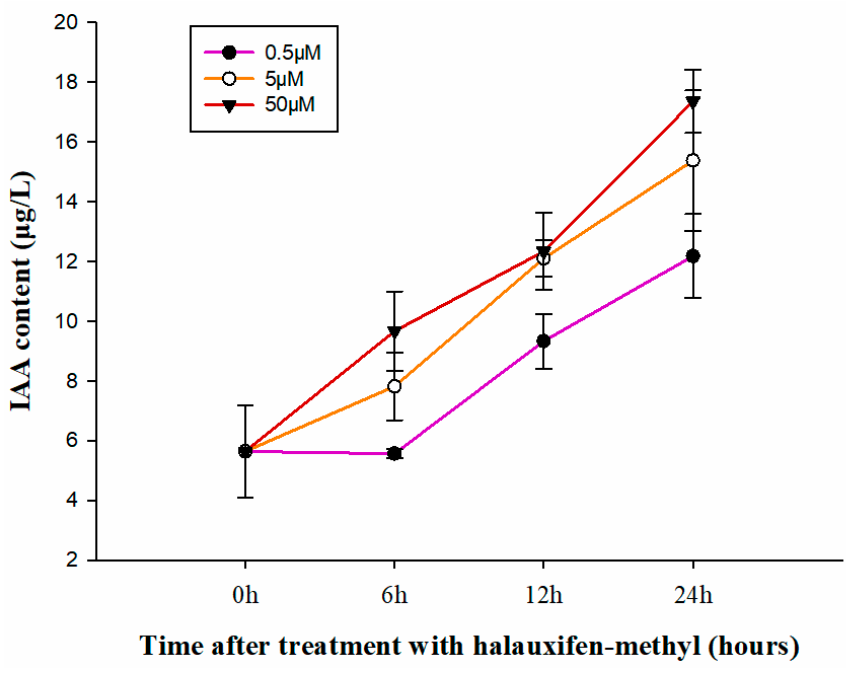
Figure 2. The effects of halauxifen-methyl on IAA levels in shoots of G. aparine . Data are expressed as percentages of the mean values for untreated control plants. Vertical bars represent the standard errors of the means.